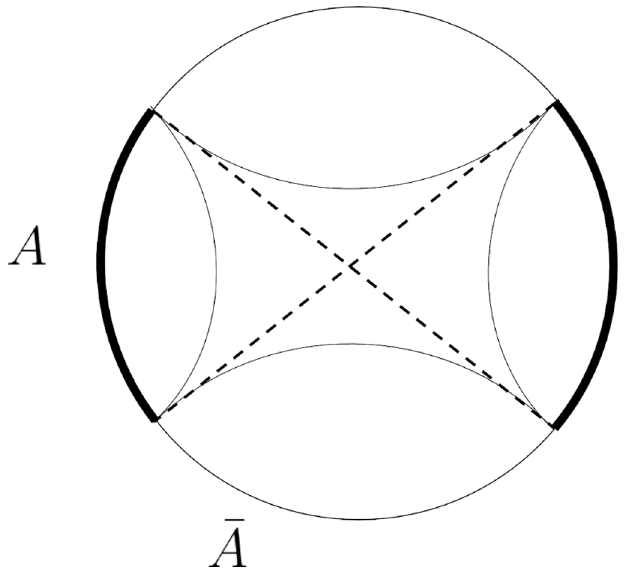
Figure 24 . Even the AdS 3 vacuum contains a Python’s Lunch when viewed as a python from the boundary region A consisting of two disjoint intervals to its complementary region (cid:22) A